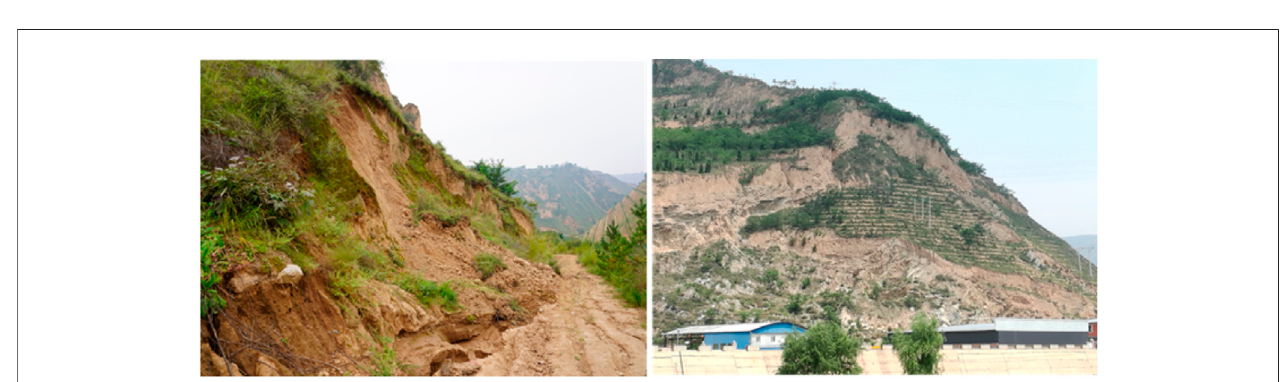
FIGURE 2 | Field photos of two loess landslides.